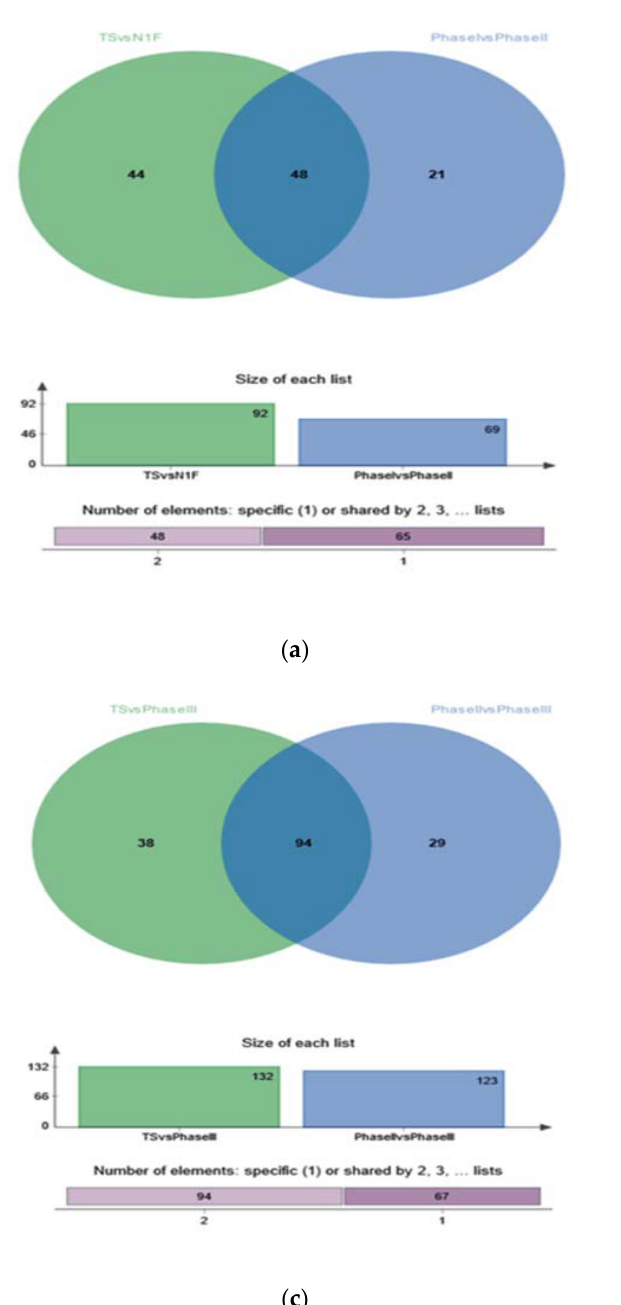
Figure 6. VENN diagrams of differential metabolites among different metabolic groups. ( a ): Venn_ TS vs N1F, Phase I vs Phase II. ( b ) Venn ‐ TS vs N1F, Phase II vs Phase III. ( c ): Venn ‐ TS vs phase III, b ) Venn-TS vs N1F, Phase II vs Phase III. ( c ): Venn-TS vs phase III, Phase II vs Phase III TS vs N1F, Phase I vs Phase II. ( Phase II vs Phase